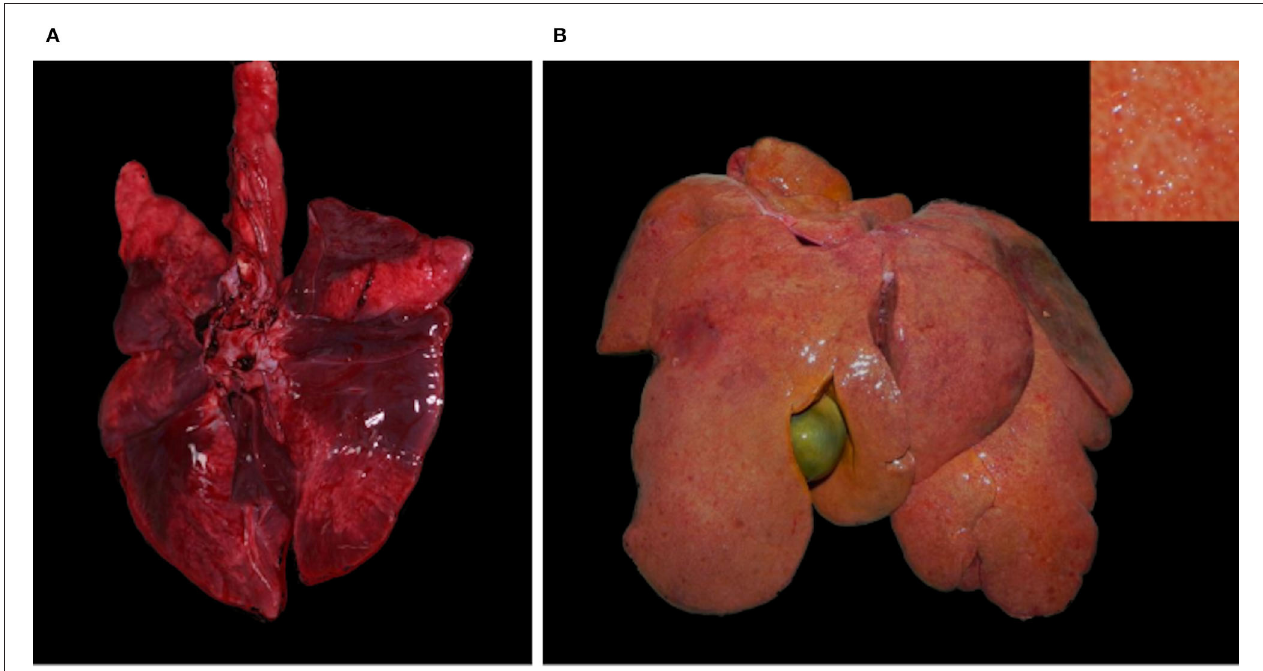
FIGURE 5 | Extra-cardiac lesions, Eurasian lynx ( Lynx lynx carpathicus ); (A) case 3, lung; multifocal to coalescent large red foci (atelectasis) and ≪ wet-like ≫ appearance (edema); (B) case 4, liver; prominent lobular pattern (inset) with diffuse orange to yellow coloration of the parenchyma.